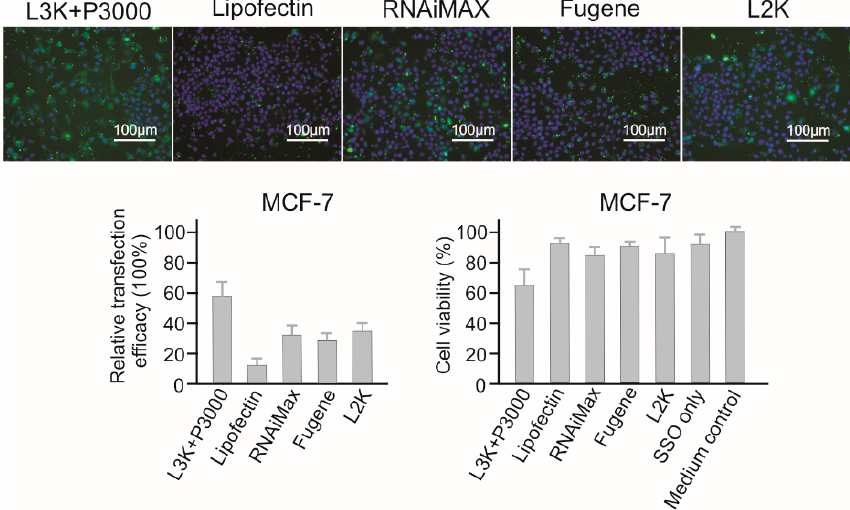
Figure 10. In vitro transfection efficiency and cytotoxicity of different transfection reagents in MCF-7 cells. L3K: Lipofectamine 3000, L2K: Lipofectamine 2000.